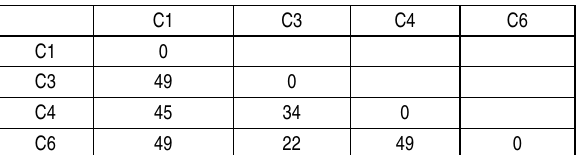
Table 22. Proximities matrix